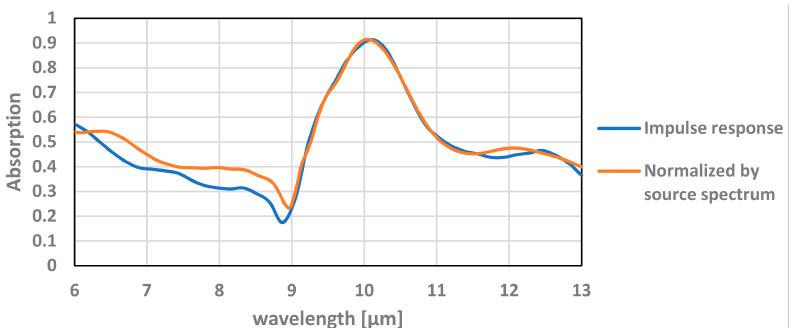
Figure 12. Absorption of the TMOS transistor with a TiN layer thickness of 20 nm located at 1.58 µ m (see Figure 10) as a function of the wavelength.